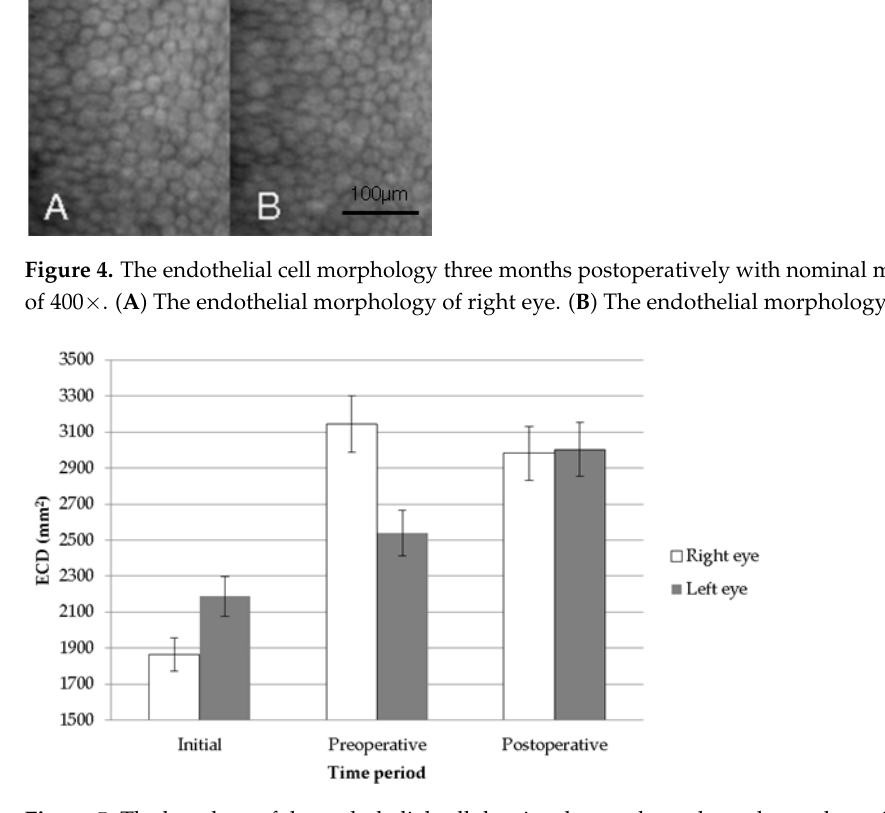
Figure 5. The bar chart of the endothelial cell density change throughout the study period.